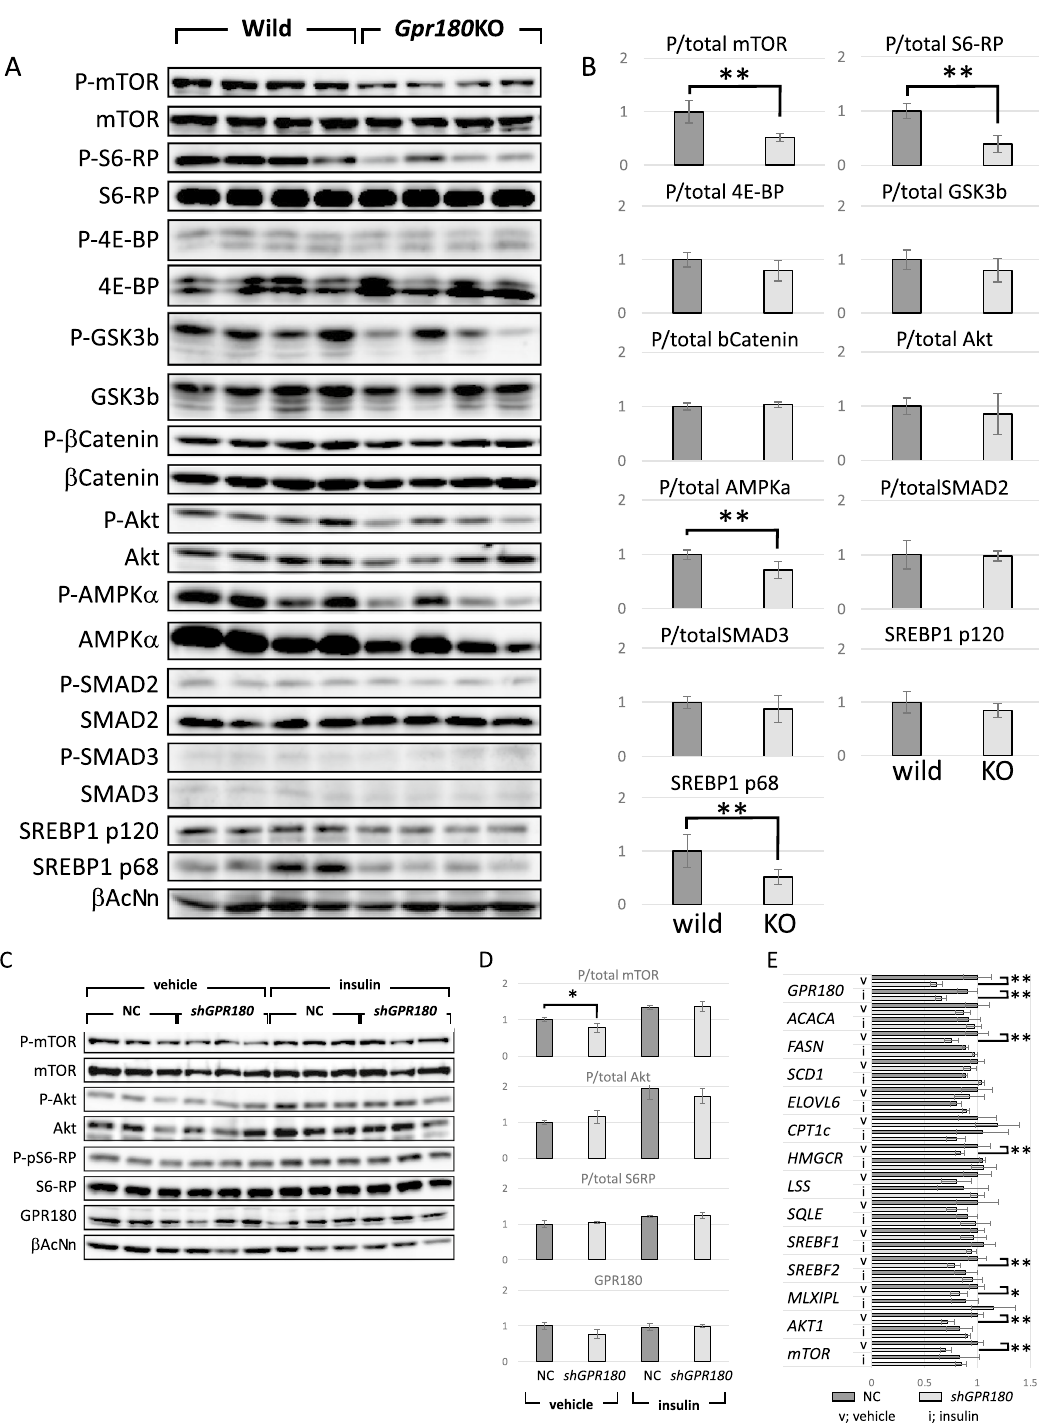
Figure 4. Western blotting and relative quantification of mouse liver proteins, and validation using a human hepatoma cell line. ( A ) Twenty micrograms of protein per liver sample of wild-type and KO mice were stained with the primary antibodies indicated on the left and HRP-labeled secondary antibody. ( B ) Relative band intensities against the normalized mean value of wild-type mice are shown as mean values with standard deviation (n = 8). ( C ) Twenty micrograms per sample of Huh7 cells transfected with pAAV-U6-negative control (NC) or pAAV-U6-shGPR180 plasmid for 24 h and subsequently stimulated with 100 nM insulin or without insulin (vehicle) were stained with the primary antibodies indicated on the left. ( D ) Relative band intensities against the normalized mean value of NC are shown as mean values with standard deviation (n = 6). ( E ) Relative mRNA levels in Huh7 cells against the normalized mean value of NC are shown as mean values with standard deviation (n = 6). *p < 0.05. **p <